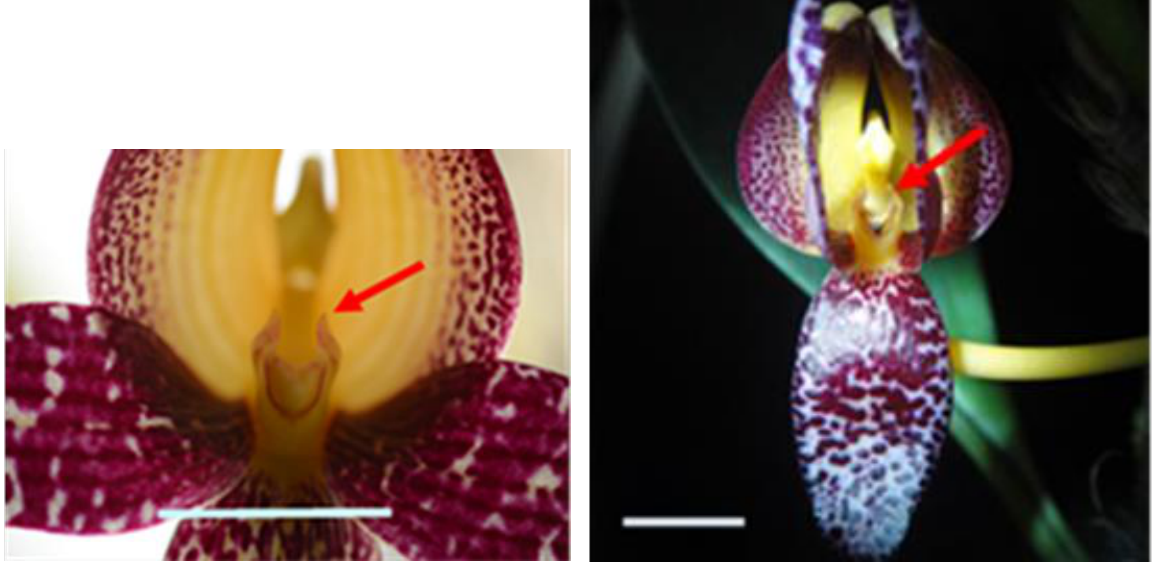
F IGURE 2. Acute tooth (arrow) on each column wall of Bulbophyllum praetervisum flower. Bar: 1 cm – Left: Flower fully bloomed in the morning. Rigth: Flower partially closed after pollinia removal – sometimes no tooth movement (at 21:00